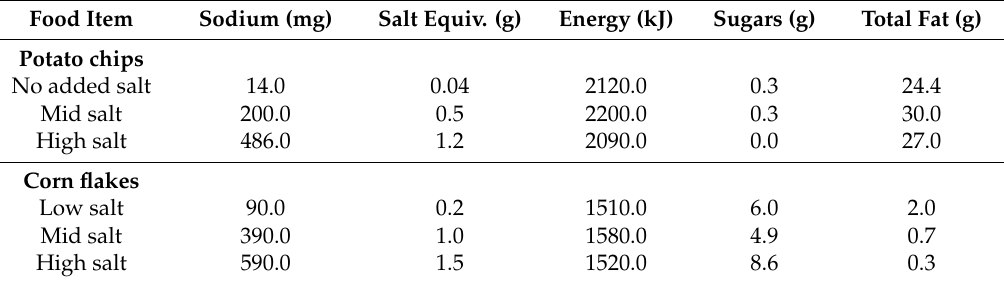
Table 1. Sodium (i.e., salt) content of potato chip and corn flake samples (per 100